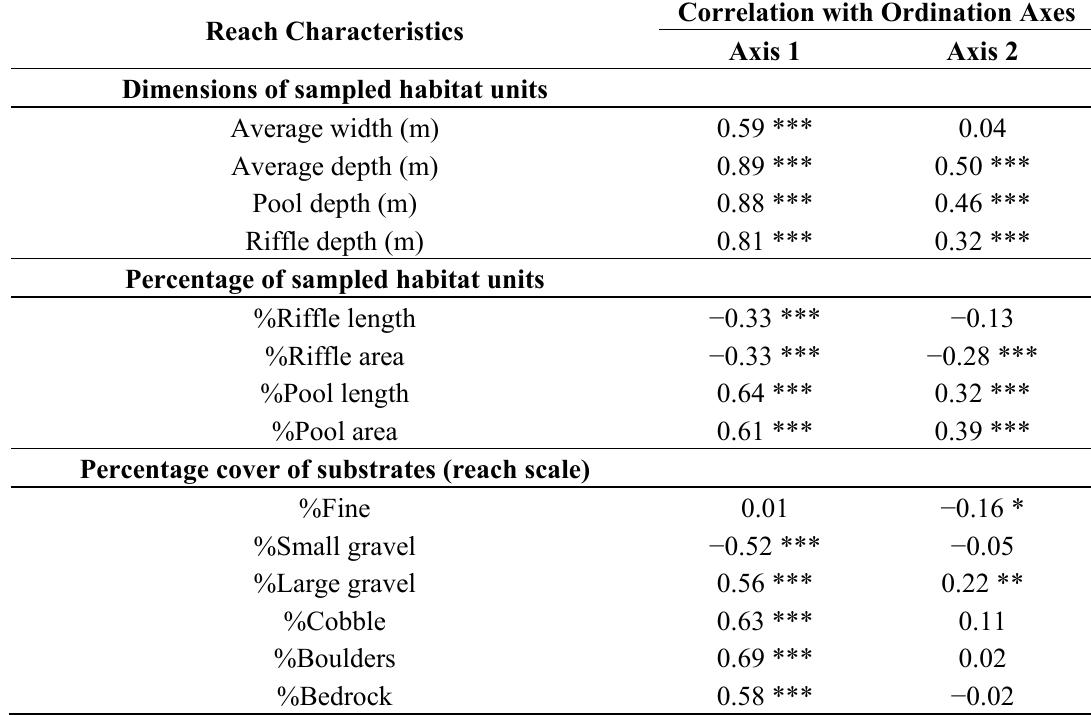
Table 2. Correlations of variables in the ordination of reach characteristics ( i.e. , main matrix) with non-metric multidimensional scaling ordination axes (Figure